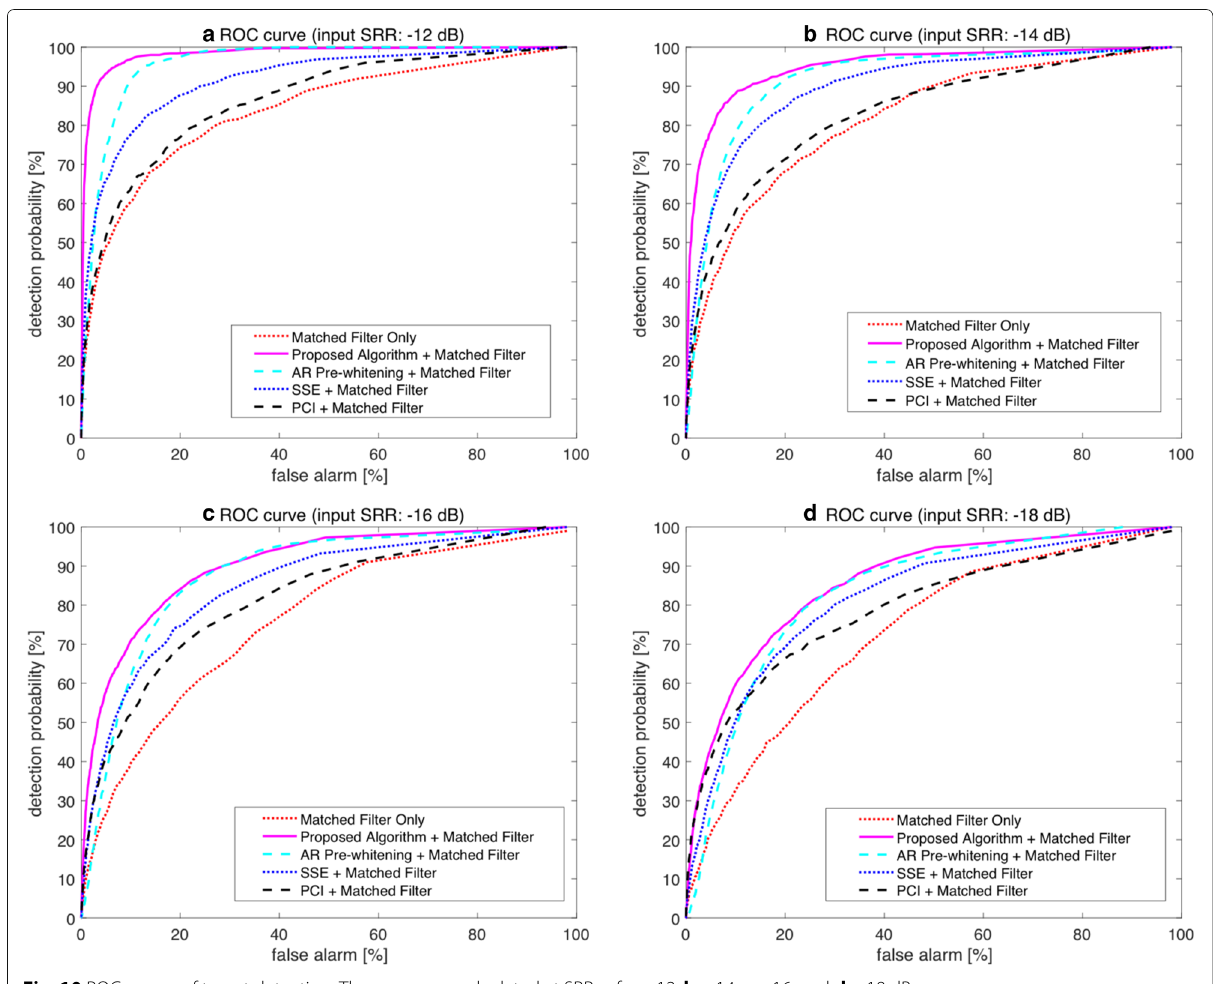
Fig. 10 ROC curves of target detection. The curves are calculated at SRRs of a − 12, b − 14, c − 16, and d − 18